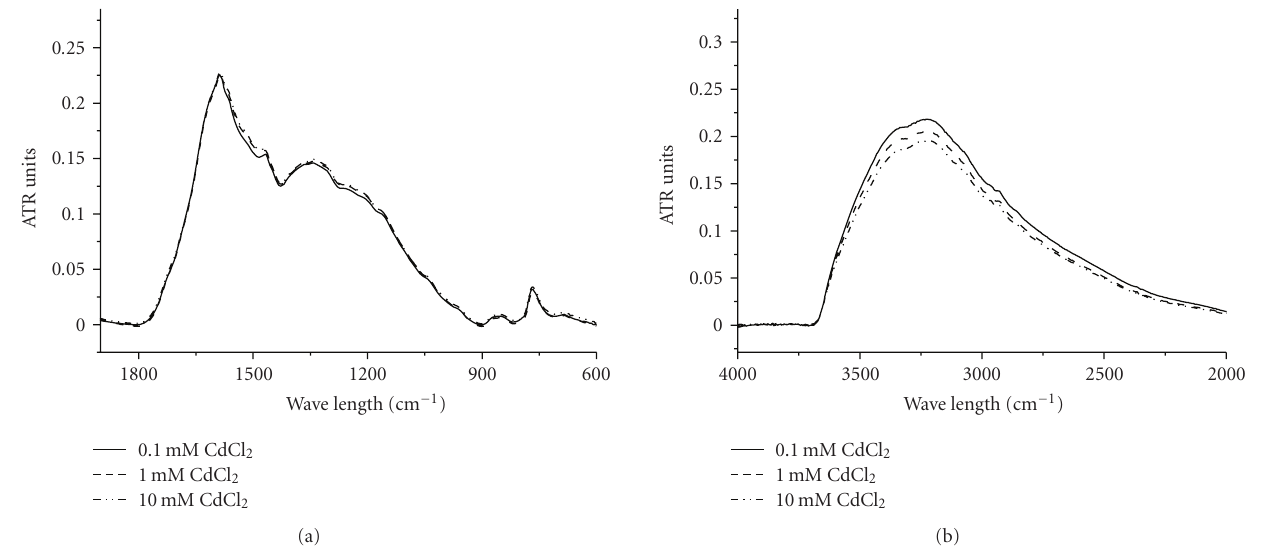
Figure 3: IR spectrum of heavy metal enriched squid melanin as a function of the solution concentration of Cd(II) in spectral region of (a) 900–1900 cm − 1 ; (b) 2000–4000 cm − 1 . The spectra are normalized to the intensity of the 1598 cm − 1 peak.